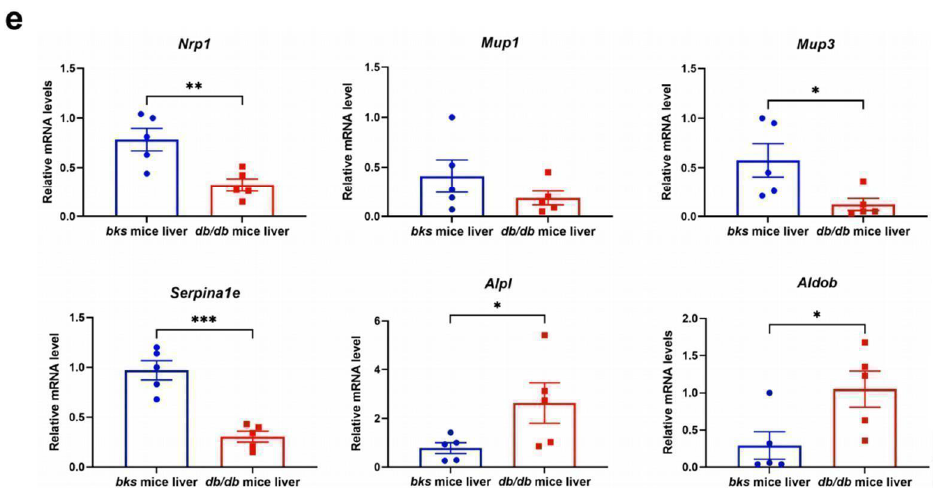
Figure 5. The confirmation of common DEPs in the sera and livers of db / db mice. ( a ) Commonly up- regulated DEPs in the sera and livers of db / db mice and bks mice ( n = 5). ( b ) Commonly downregulated DEPs in the sera and livers of db / db mice and bks mice ( n = 5). ( c ) Heatmap of the commonly upregulated DEPs. ( d ) Heatmap of the commonly downregulated DEPs. ( e ) The validations of some of the common DEPs. Red dots represent bks mice and blue squares represent db/db mice. * p < 0.05; ** p < 0.01; *** p < 0.001.